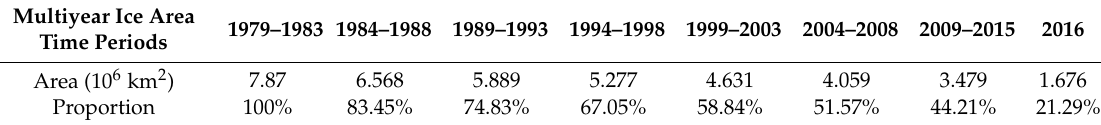
Figure 4. The results of multiyear ice in different years (1979–2016). Table 2. The statistical results of multiyear ice area and proportion.